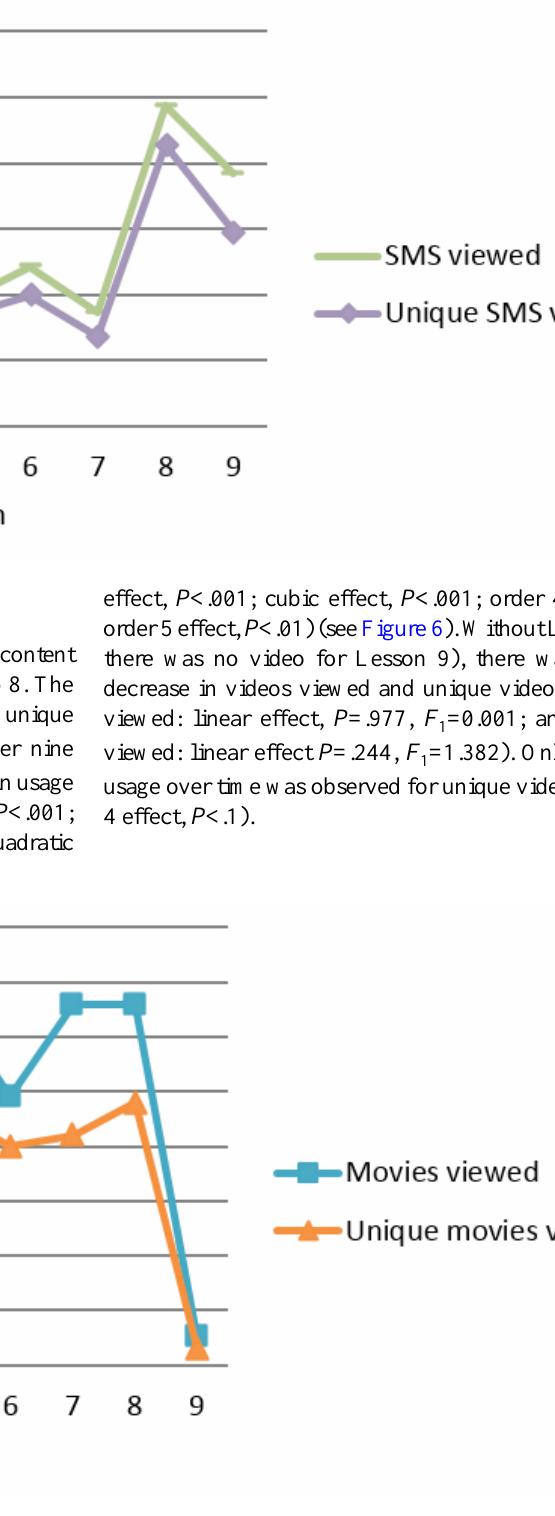
Figure 5. SMS per lesson.